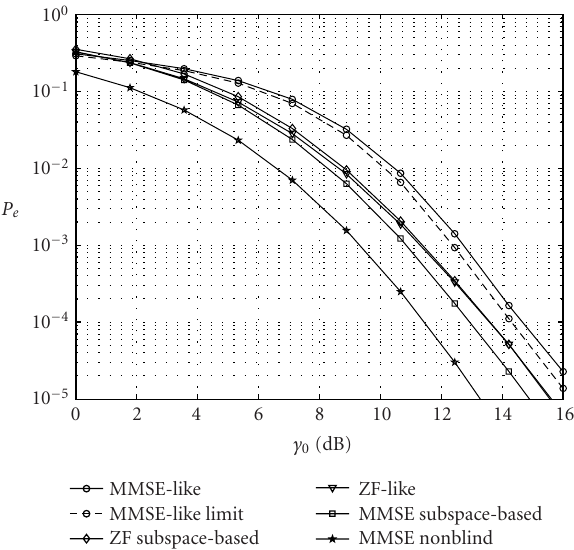
Figure 10: Probability of error for the blind receivers; noncoopera- tive reception with soft integration: K = 4, M = 8, N = 4, n t = 2, n r = 2, Q = 1300, and P =